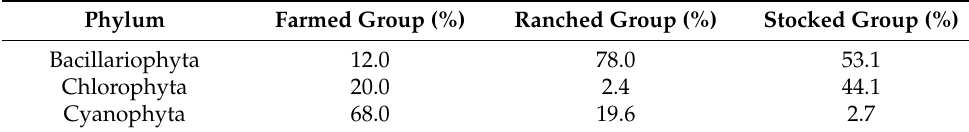
Table 6. Phytoplankton composition of three groups.